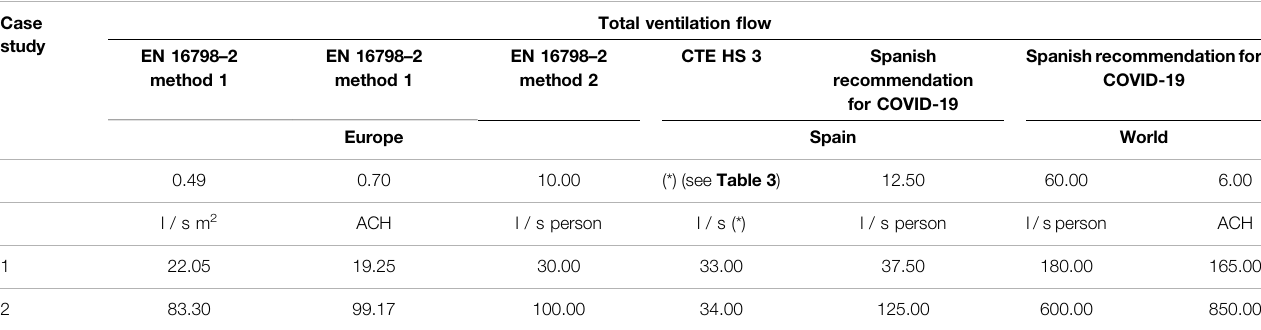
TABLE 6 | Comparison of the ventilation fl ow results by regulations. Case